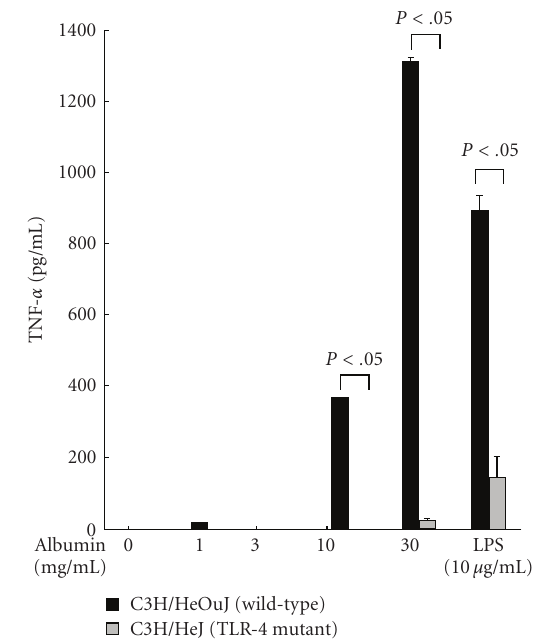
Figure 2: BSA increases TNF- α gene expression in murine peri- toneal macrophages in a TLR-4-dependent manner. Primary peri- toneal macrophages were isolated from C3H/HeJ (TLR-4 mutant) and C3H/HeOuJ (wild-type) and were treated with BSA for 24h. As expected, LPS treatment (10 μ g/mL) resulted in a significant di ff erence in TNF- α induction between macrophages isolated from C3H/HeJ mice and their wild-type counterparts. BSA treatment resulted in a dose-dependent increase in TNF- α in macrophages isolated from C3H/HeOuJ mice, but not in macrophages isolated from C3H/HeJ mice. All experiments were performed in triplicate with 3 wells per condition.